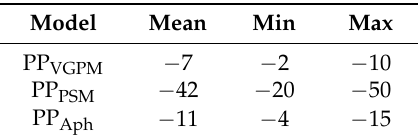
Table 3. Relative percentage difference (%) between modelled PP eu with and without photoinhibition. The negative sign “ − ” indicates how much photoinhibition reduces PP eu